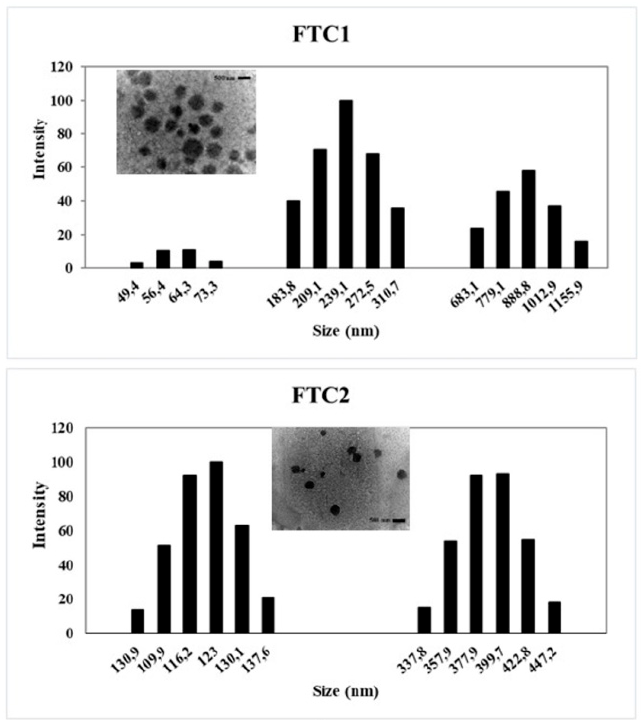
Figure 2. Size distribution and TEM micrographs (bar 500 nm) of nanoparticle (NP) folic-thiolated chitosan samples FTC1 and FTC2. Table 2. Average size, polydispersity index, zeta (Z)-potential, entrapment e ffi ciency, and drug